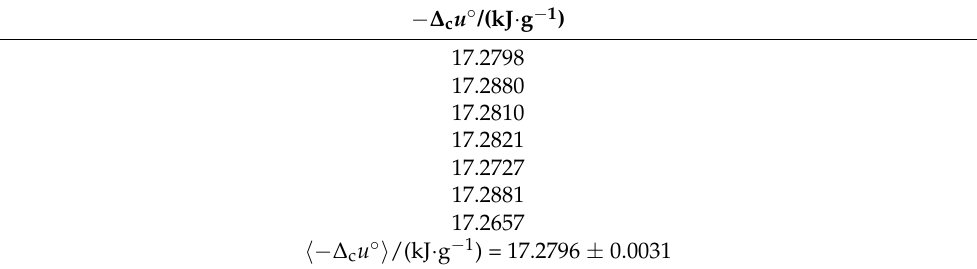
Table 3. Specific combustion energies of 1MH at T = 298.15 K and p ◦ = 0.1 MPa.